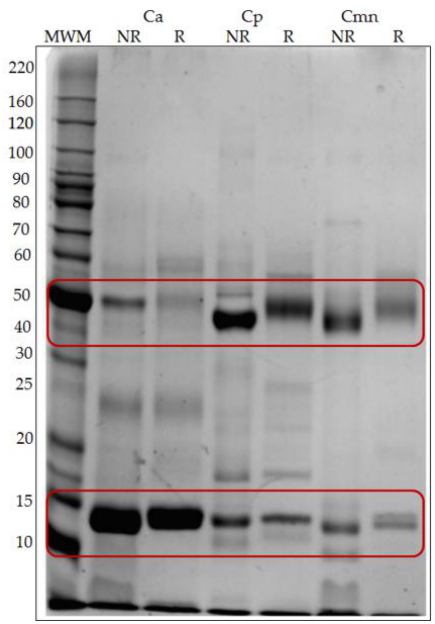
Figure 1. Sodium dodecyl sulfate polyacrylamide gel electrophoresis (SDS-PAGE) protein banding pattern for C. aquilus (Ca), C. polystictus (Cp) and C. molossus nigrescens (Cmn) venoms. Twenty micrograms of lyophilized venoms were analyzed by non-reducing (NR) and reducing conditions (R) in 10% polyacrylamide gels. MWM: molecular weight markers (kDa). Variation in the bands with molecular weight ~15 kDa and ~50 kDa are marked with red boxes.